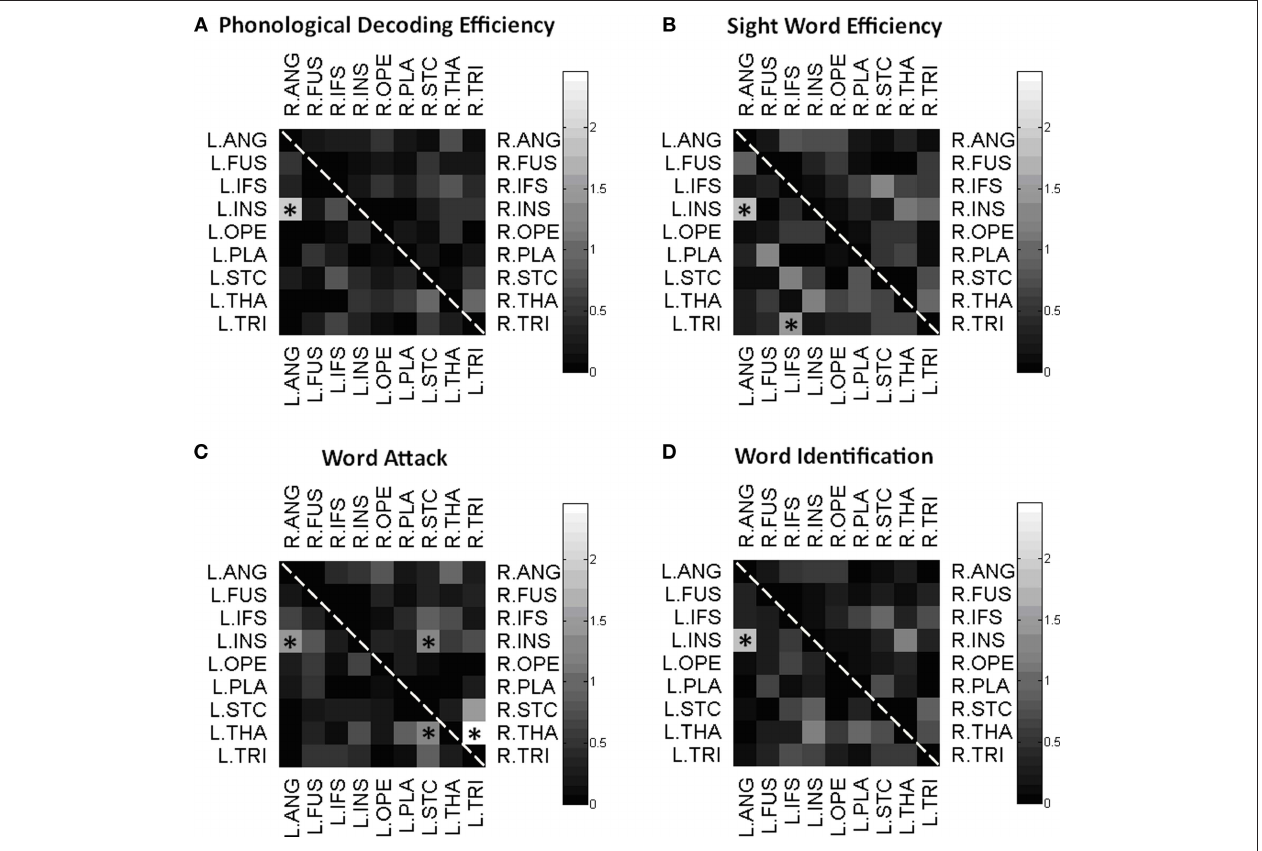
FiguRe 4 | Correlation matrices. Matrix of correlations between intra-hemispherical pairs of gray matter regions. Connectivity between each pair of ROIs is correlated with Phonological Decoding Efficiency (A) , Sight Word Efficiency (B) , Word Attack (C) , and Word Identification (D) , and the significance level of the correlation is displayed on a logarithmic scale. Significant correlations were marked by a star (* p < 0.05,